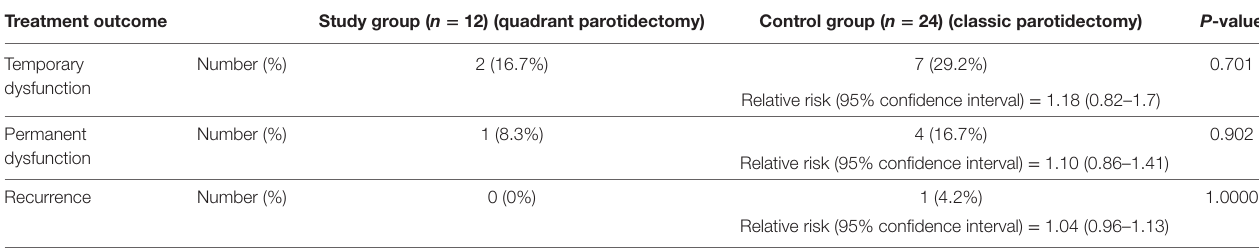
TaBle 1 | Treatment outcome of the prospective part of the study. Treatment outcome study group ( n = 12) (quadrant